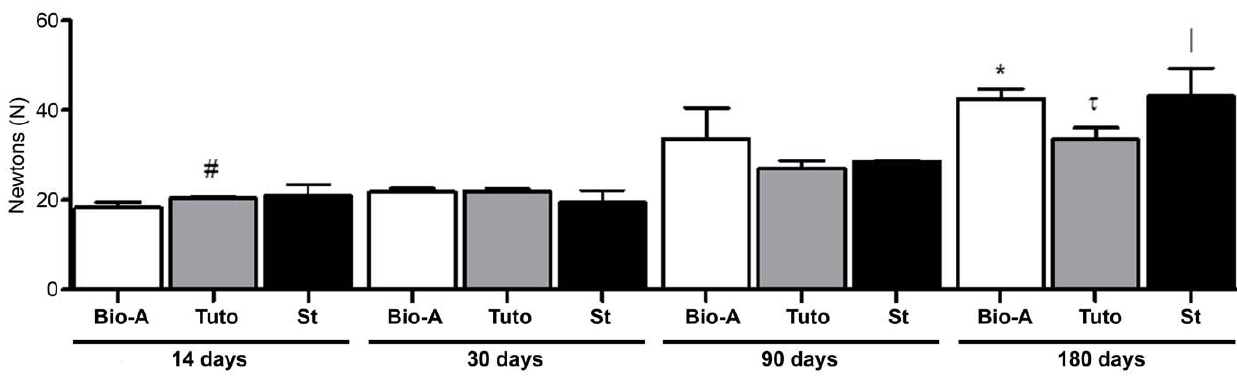
Figure 9. Biomechanical strength of the different meshes. The results (Newtons) were expressed as the mean 6 SEM at 14, 30, 90 and 180 days post-implantation. Bio-A : *, vs. 14 days and 30 days ( P , 0.01). Tuto : # , vs. 90 days ( P , 0.01); t , vs. 14 days and 90 days ( P , 0.05) and 30 days ( P , 0.01). St : |, vs. 14 days and 30 days ( P , 0.05).